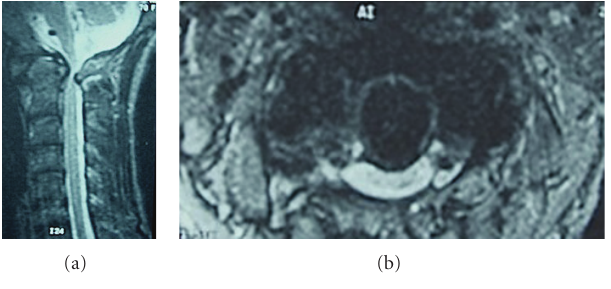
Figure 1: Sagittal (a) and axial (b) T2-weighted image MRI scans of the cervical spine demonstrating hypoplastic posterior arch of the atlas causing severe canal stenosis and spinal cord compression.